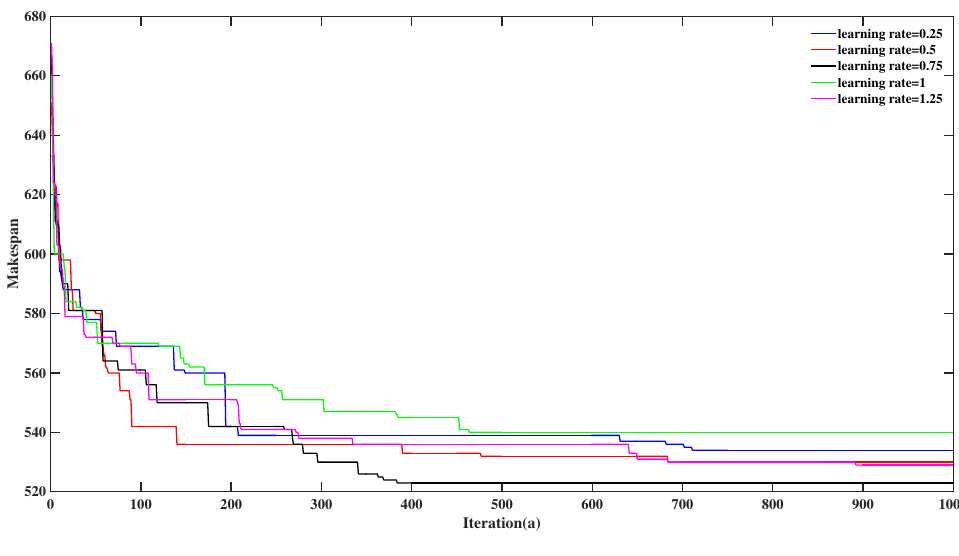
Figure 10. Experiment to determine learning rate.